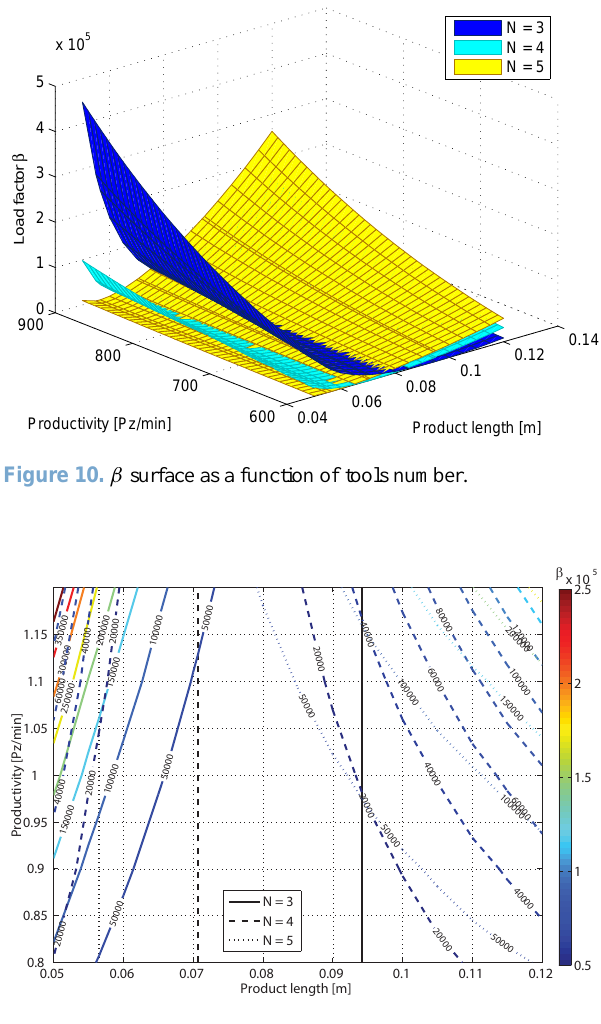
Figure 11. β as a function of input